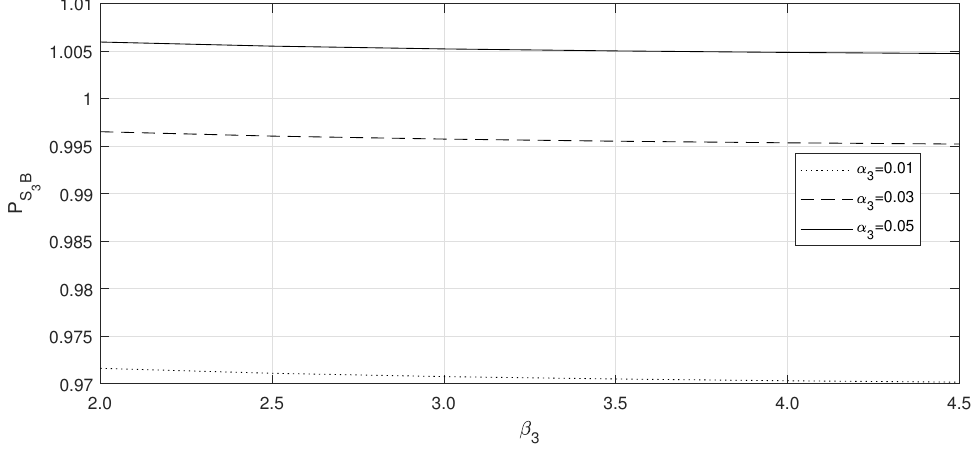
Figure 7. Probability that Server-3 is busy on α 3 vs. β 3 . Table 2. Interpretation of parameters on